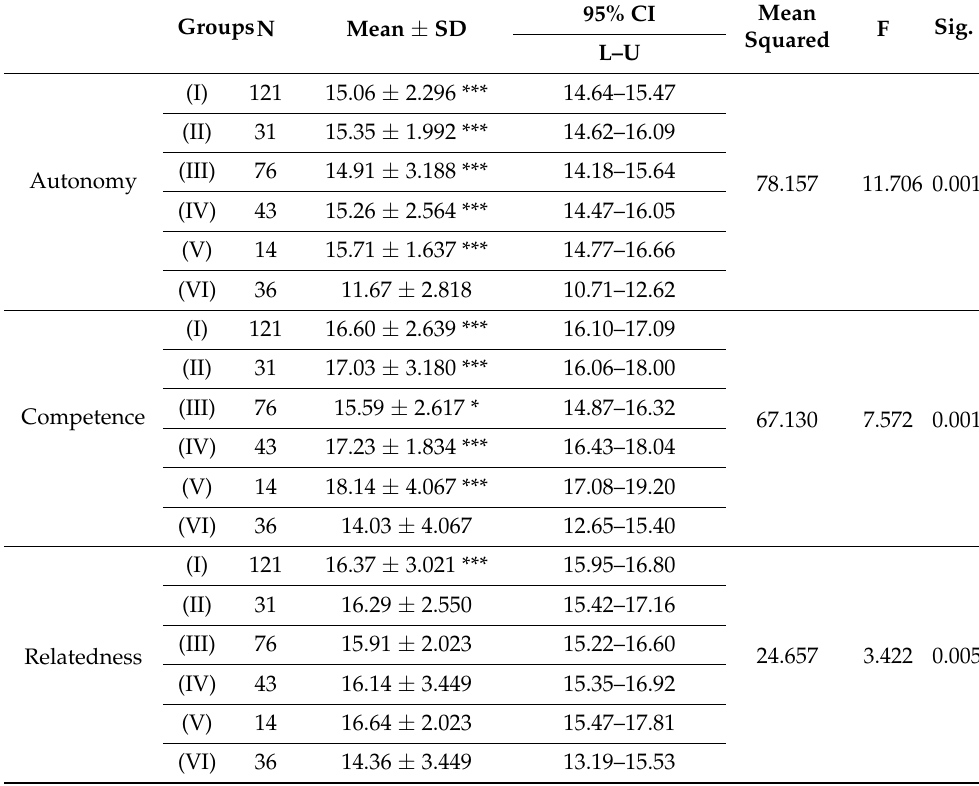
Table 3. Effect of the variable of physical activity practiced on autonomy, competence, and